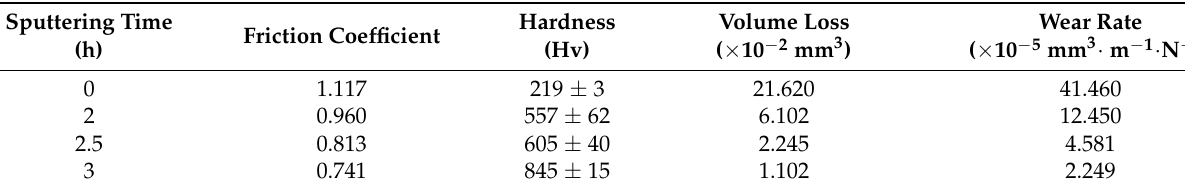
Figure 8. Comparison of the ( a ) Friction Coefficient, Hardness and ( b ) Volume Loss and Wear Rate of CrN films with different sputtering time. Table 3. Friction coefficient, hardness, volume loss, and wear rate of CoCrNiSi 0.3 MEA without and with CrN films deposited for different times.